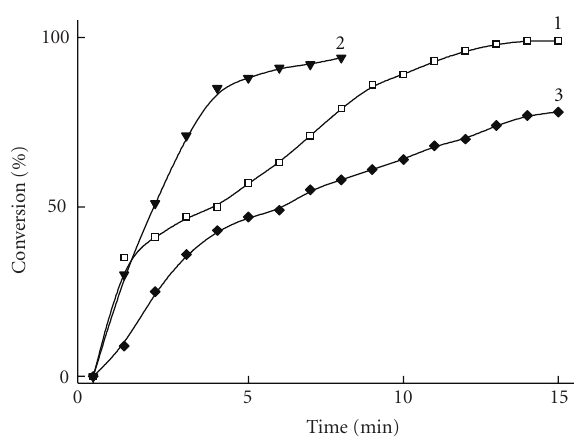
Figure 2: MMA conversion on irradiation time. 1: MMA + 5wt% Pht, 2: MMA + 5 wt% Pht + 10 wt% PI 1, 3: MMA + 5wt% Pht + 10wt% Diimide.